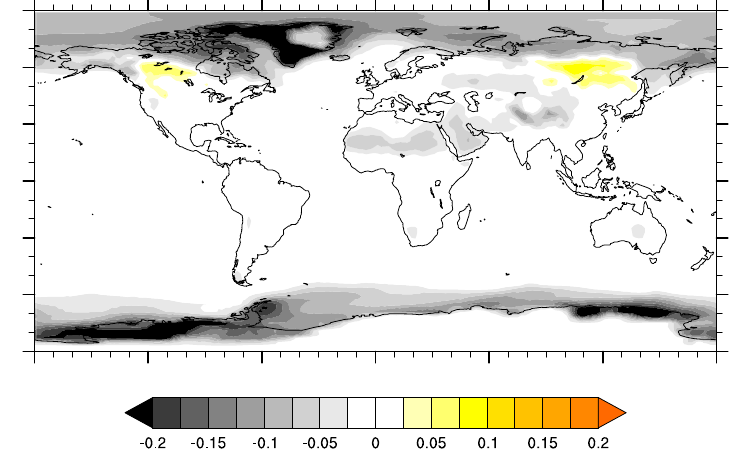
Fig. 6. Spatial distribution of multi-model mean changes in the clear sky albedo between mid-Pliocene and pre-industrial simulations. This primarily shows changes due to specified vegetation and global ice sheets and modelled sea ice and snow cover, although it includes an atmospheric component. Greyscale shows reductions in albedo, generally associated with warming and yellow shading indicates increases in albedo that would generally cause a reduction in surface air temperature. Increases in albedo closely follow the northward expansion of grassland imposed on the simulations (Haywood et al.,